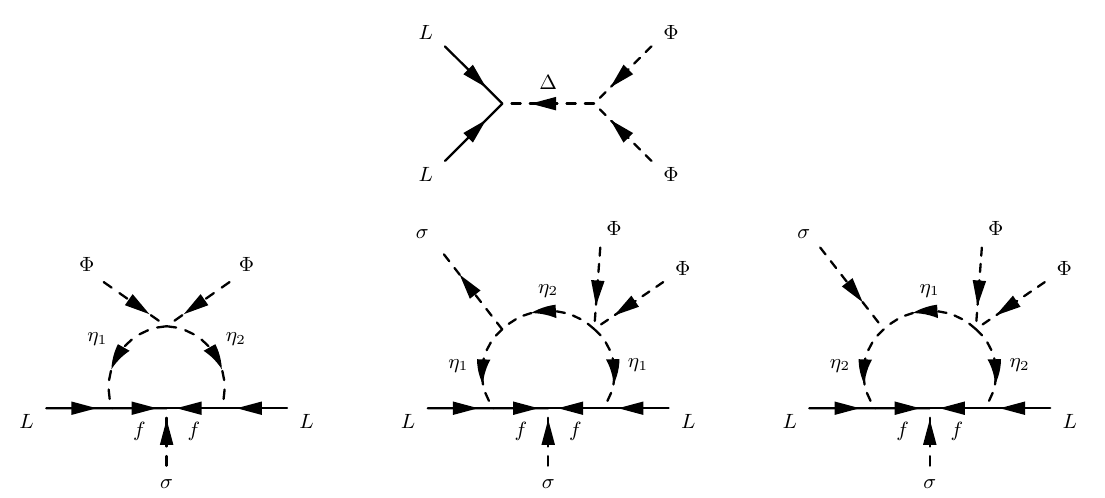
Figure 1 . First row: type-II seesaw contribution to the dimension-5 effective mass operator LL ΦΦ . Second row: (scotogenic) one-loop contributions to the dimension-6 operator LL ΦΦ σ (left diagram) and dimension-7 operators LL ΦΦ σσ ∗ and LL ΦΦ σσ (centre and right diagrams,